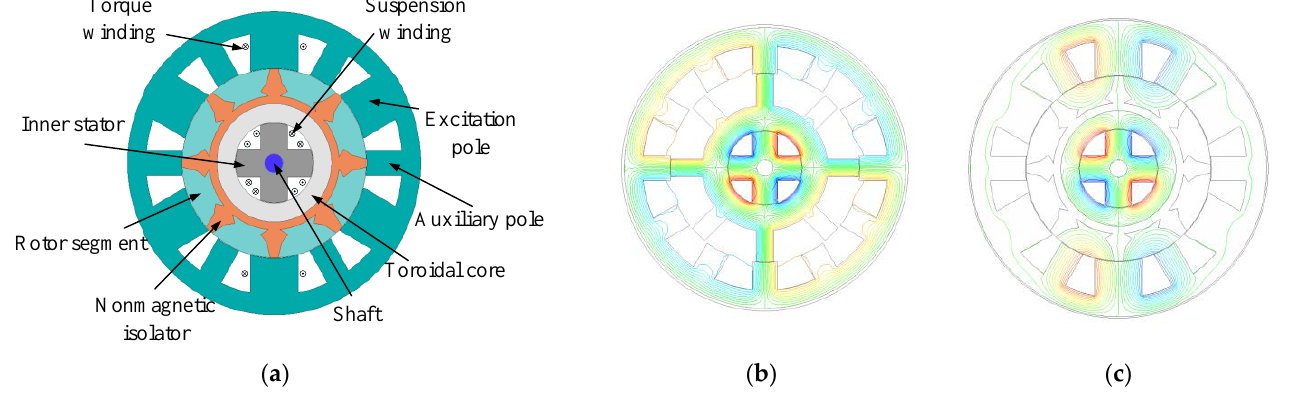
Figure 8. Segmental rotor type 12/8 DSBSRM: ( a ) Motor structure; ( b ) Magnetic flux distribution of conventional 12/8 DSBSRM; and ( c ) Magnetic flux distribution of segmental rotor type 12/8